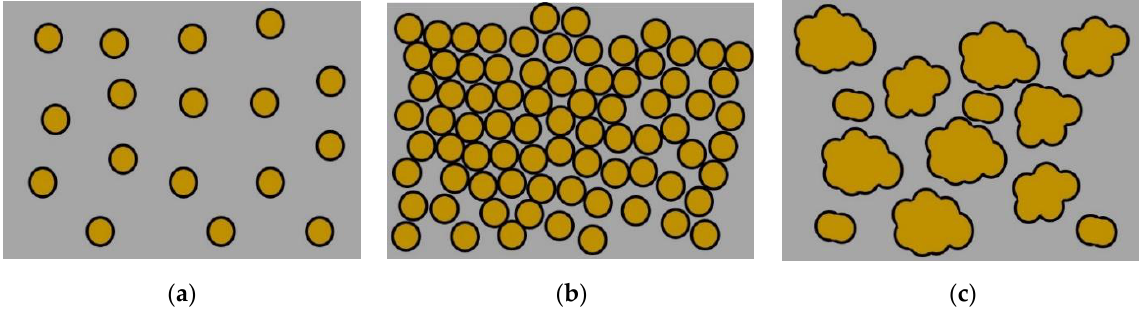
Figure 14. The dispersion state of mineral powder in the mastic.